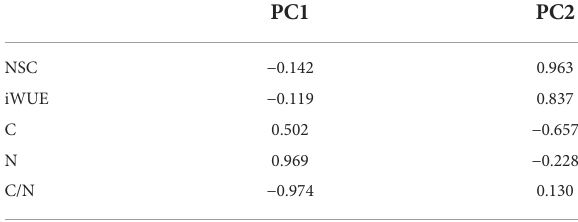
TABLE 3 Principal component analysis correlation matrix of physiological indices for three parts of C. lanceolata in four